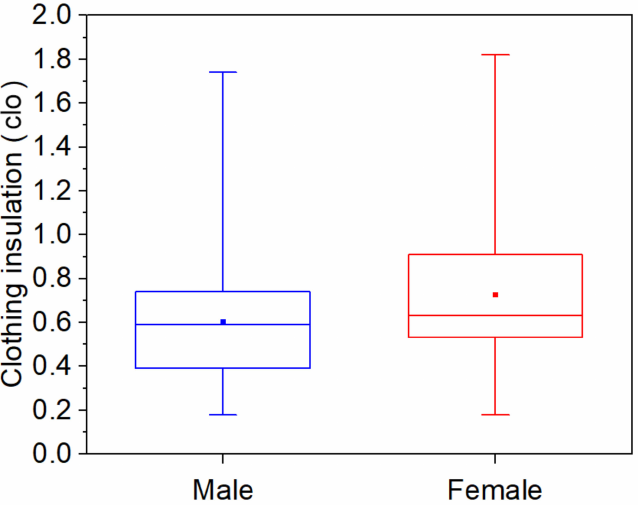
Figure 2. Clothing insulation level by gender. Whiskers stand for minimum and maximum